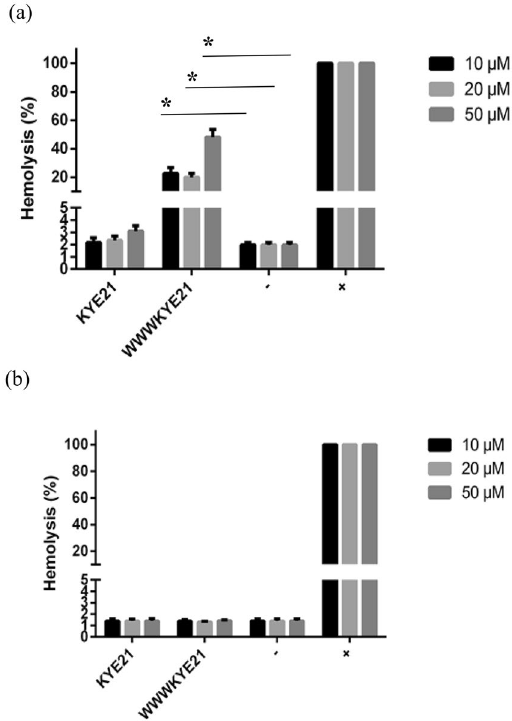
Figure 8. Hemolysis of erythrocytes in PBS ( a ) and 50% citrate blood ( b ) of KYE21 and WWWKYE21 at the indicated concentrations. Shown also are results from positive ( + ) and negative ( − ) controls. (n = 3; mean ± SD shown) * p < 0.05 compared to absence of